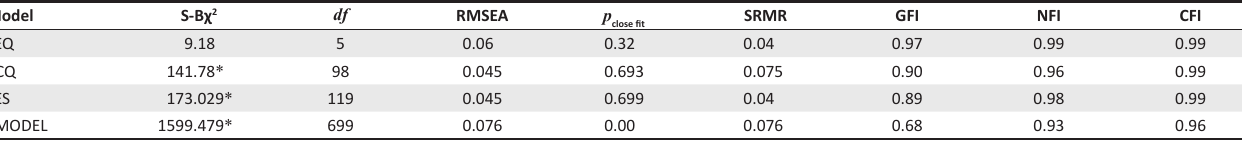
TABLE 2: Goodness-of-fit indices for the measurement and structural models.